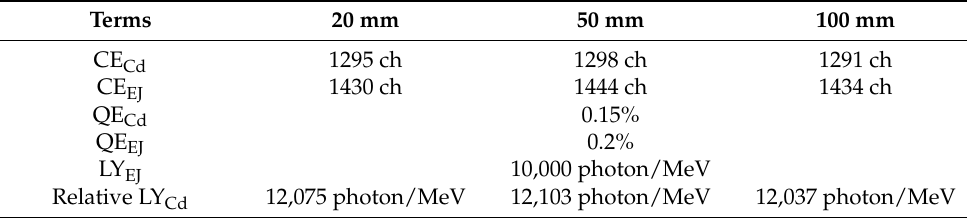
Table 3. Compared relative light yield by distance to Cs-137 gamma ray source.